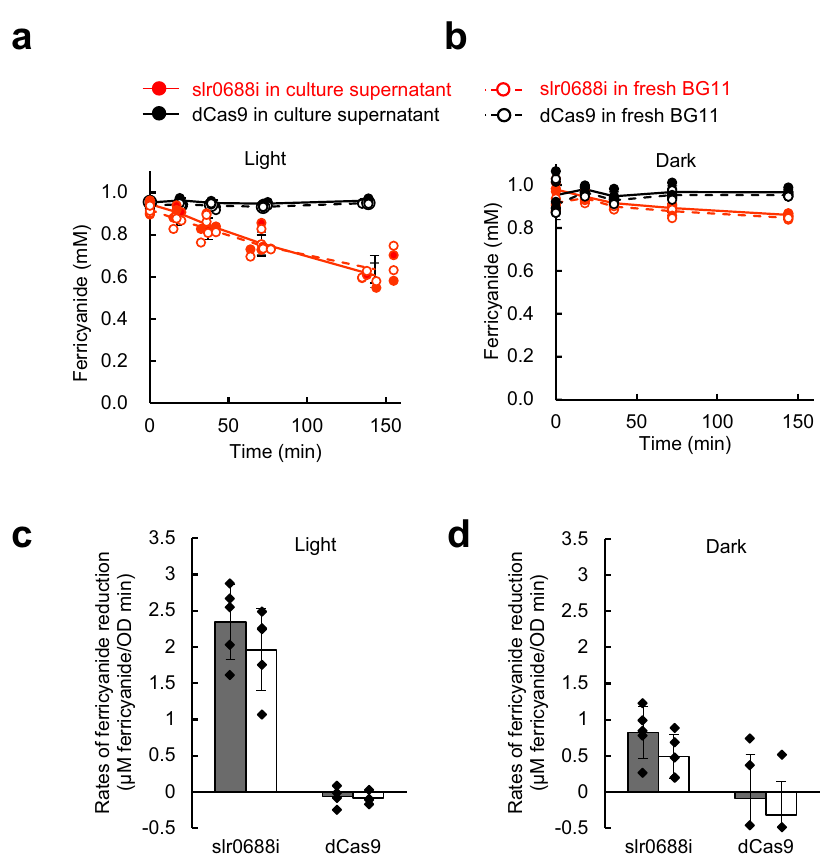
Fig. 3 Rate of ferricyanide reduction by Synechocystis cells. Time-dependent reduction of ferricyanide ( a ) under illumination and ( b ) in the dark by slr0688i (red) and dCas9 (black). Each strain was suspended either in their respective culture supernatant (solid lines and closed data point symbols) or in fresh BG11 (dashed lines and open data point symbols) containing 1 mM potassium ferricyanide, and the ferricyanide concentration was measured. Data are presented as mean values± SD of biologically independent experiments ( n = 4 for dCas9 under illumination and n = 5 for the others). Rates of ferricyanide reduction ( c ) under illumination and ( d ) in the dark by slr0688i and dCas9 suspended in their respective culture supernatants (gray) or in fresh BG11 (white) were then calculated. Data are presented as mean values ± SD of biologically independent experiments ( n = 4 for dCas9 under illumination and n = 5 for the others). Source data are provided as a Source Data fi